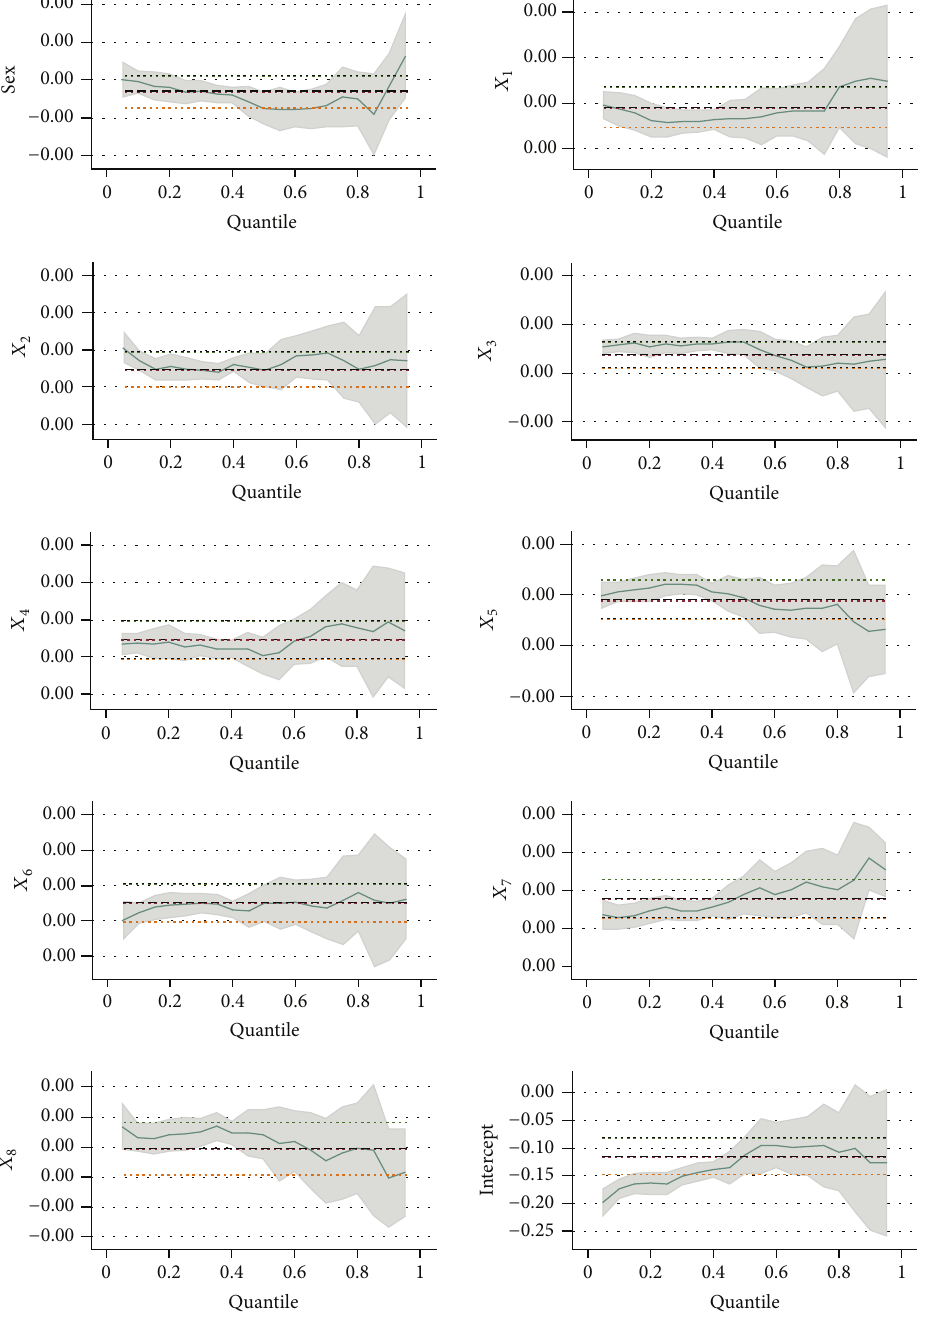
Figure 3: Output of analysis results of least square regression model and quantile regression model for overall satisfaction